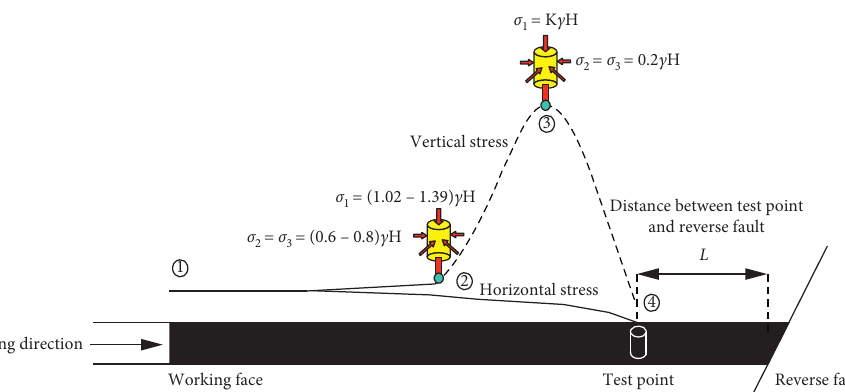
Figure 18: Stress change of coal in reverse fault area under dynamic